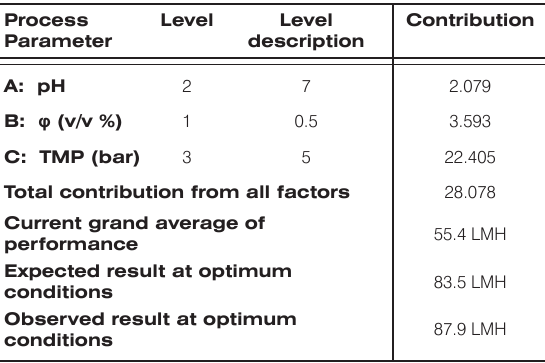
Table 7. The highest flux is achieved at pH = 7, φ = 0.5%